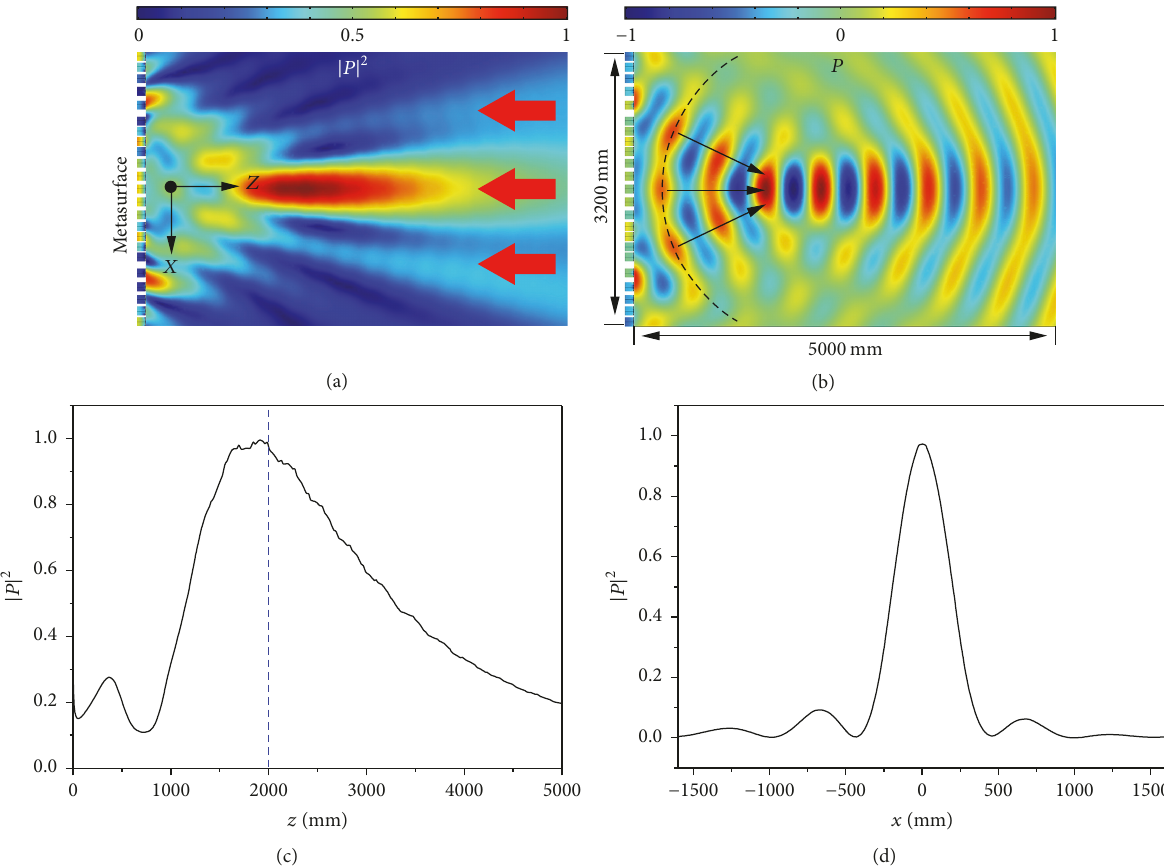
Figure 5: Planar acoustic lens. (a) The squared absolute pressure field of reflected waves. The red arrows represent the propagation direction of incident plane wave. (b) The transient pressure field distribution of reflected waves. The black dashed arc indicates the shape of reflected wavefront. (c) The longitudinal sound intensity distribution at 𝑥 = 0. (d) The transverse distribution of intensity at 𝑧 = 2000